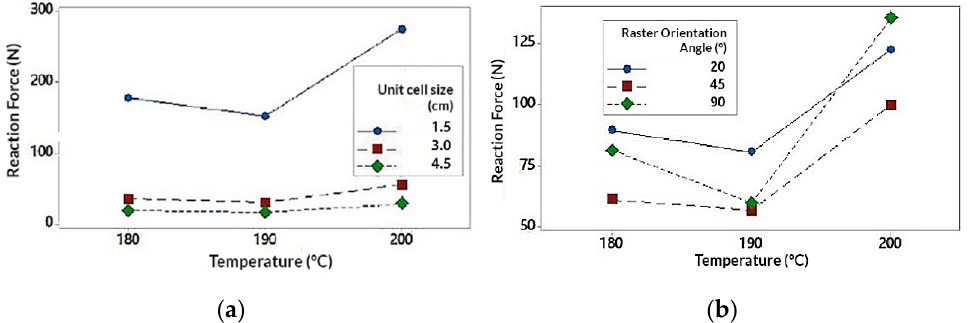
Figure 7. Interaction graph on temperature (T); ( a ) Temperature (T) in relation to unit size (U); ( b ) Temperature (T) in relation to the orientation angle (R).